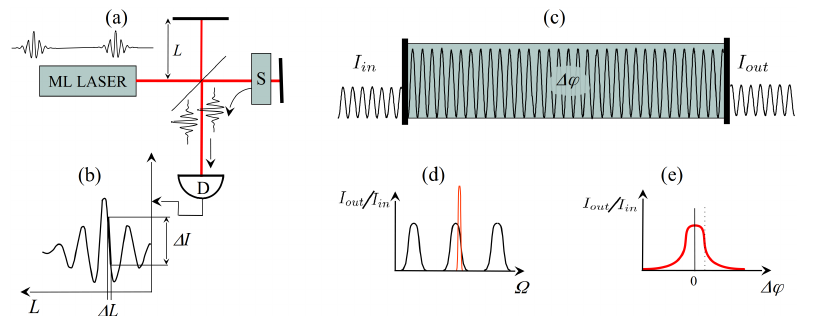
Figure 1. Passive interferometry. ( a ) the Michelson; ( b ) the phase detection proceeds via an amplitude measurement of interfering beams; ( c ) sensitivity enhancement using a high-Q resonator; ( d ) Fabry– Perot resonances vs. optical frequency. The higher the finesse, the narrower the transmission peaks. For optimum sensitivity, the laser linewidth should be narrower than the transmission peaks. ( e ) A phase shift ∆ ϕ within the interferometer (initially at resonance) results in a drop in